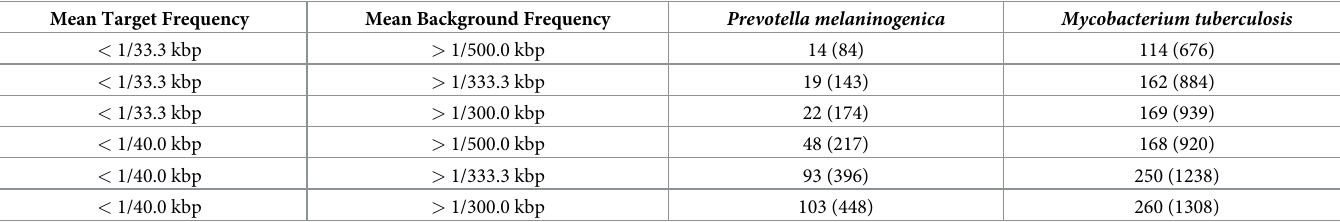
Table 5. P. melaninogenica is a more difficult genome to design primers for than M. tuberculosis . Searching the two genomes with the same parameters during Stages 2 and 3 produces much larger lists of candidate primers for M. tuberculosis than for P. melaninogenica . Values are the number of candidate primers remaining after Stage 3 (parenthetical numbers are the candidate primers remaining after Stage